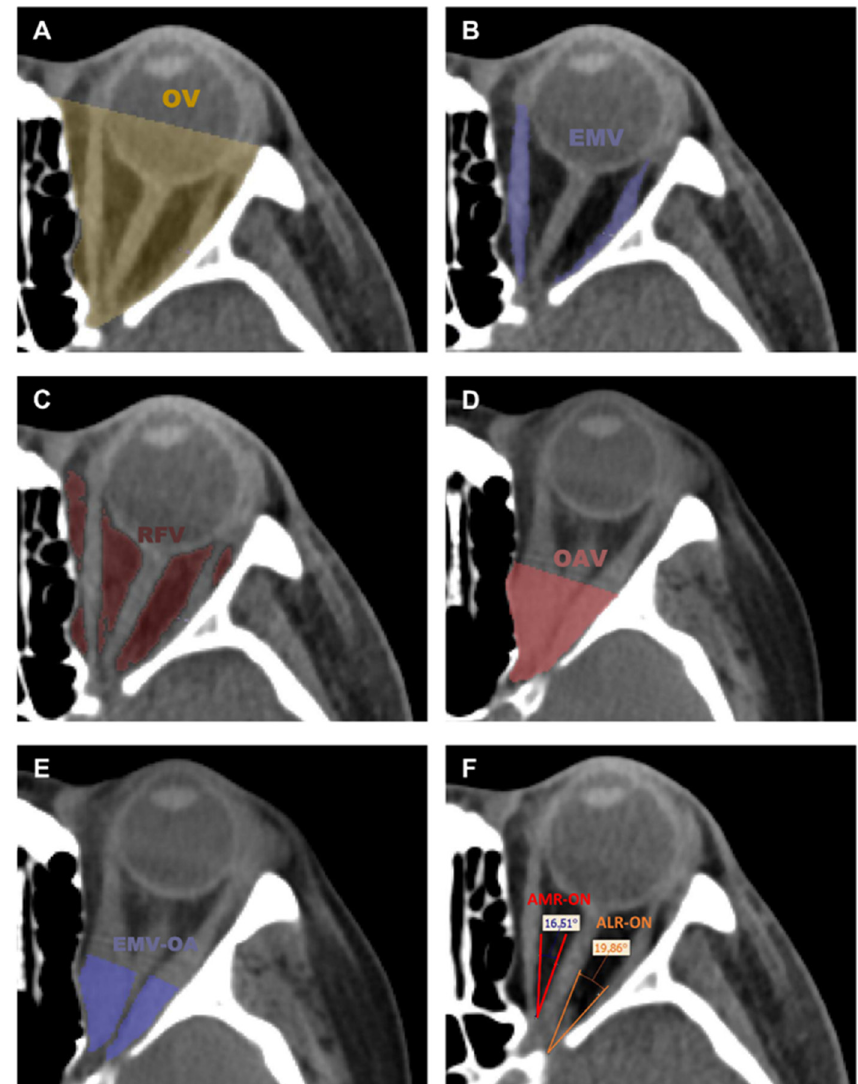
Figure 2. Axial CT slices with the highlighted segmented tissues. ( A ) orbital volume (OV), ( B ) ex- traocular muscle volume (EMV), ( C ) retroorbital fat volume (RFV), ( D ) orbital apex volume (OAV), ( E ) extraocular muscle volume in orbital apex (EMV-OA), ( F ) the angle between the medial rectus